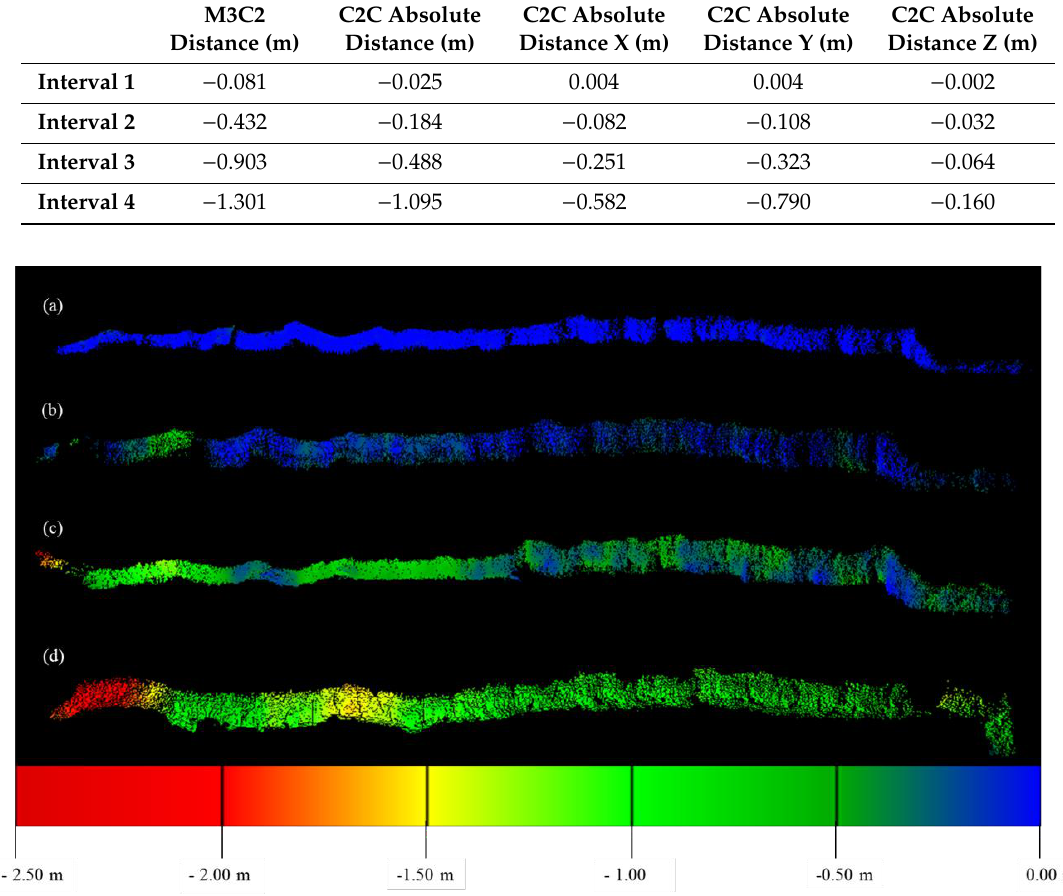
Figure 4. Cloud-to-Cloud (C2C) change analysis results for ( a ) interval 1, ( b ) interval 2, ( c ) interval 3, and ( d ) interval 4.